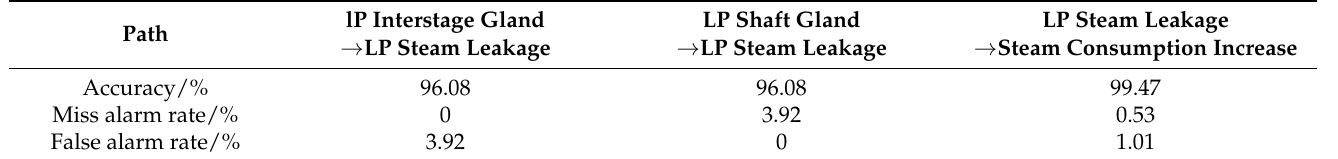
Table 3. Low pressure (LP) fault propagation inference precision.